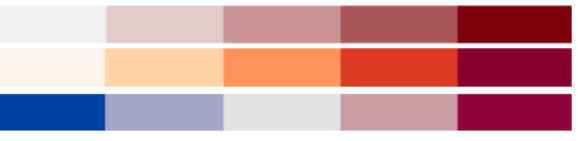
Figure 6. Examples of the used HCL color